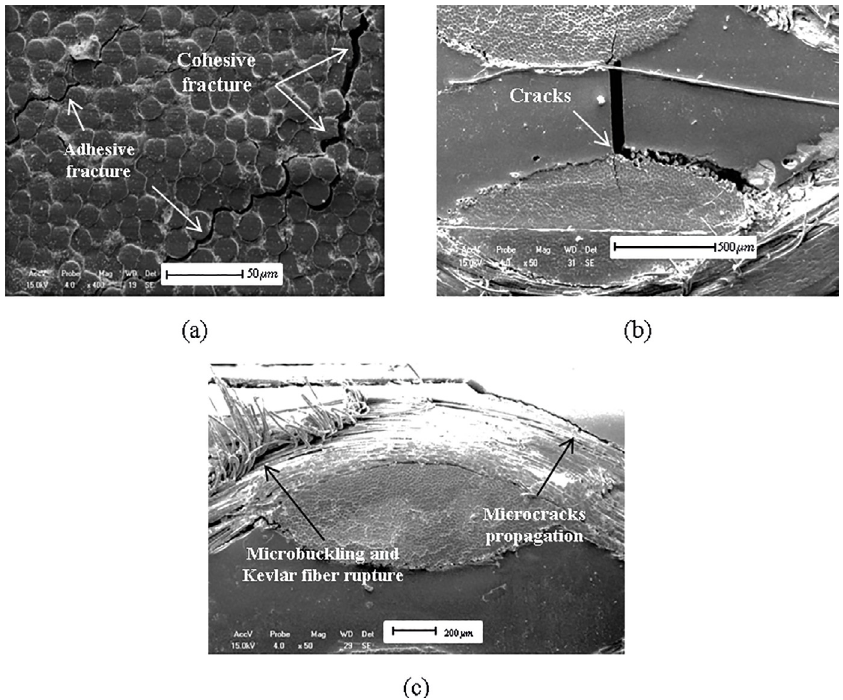
Figure 10. Fracture characteristics - HSCL laminate.